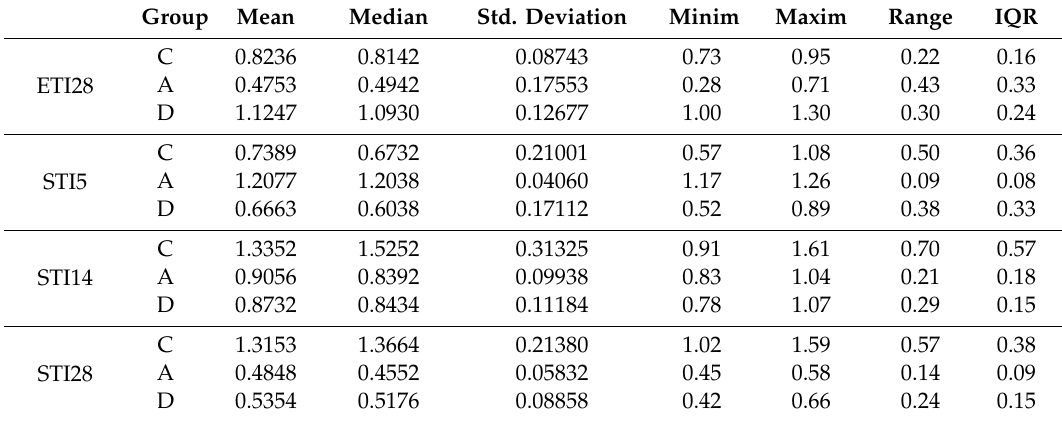
Table 2. Kruskal–Wallis test results.